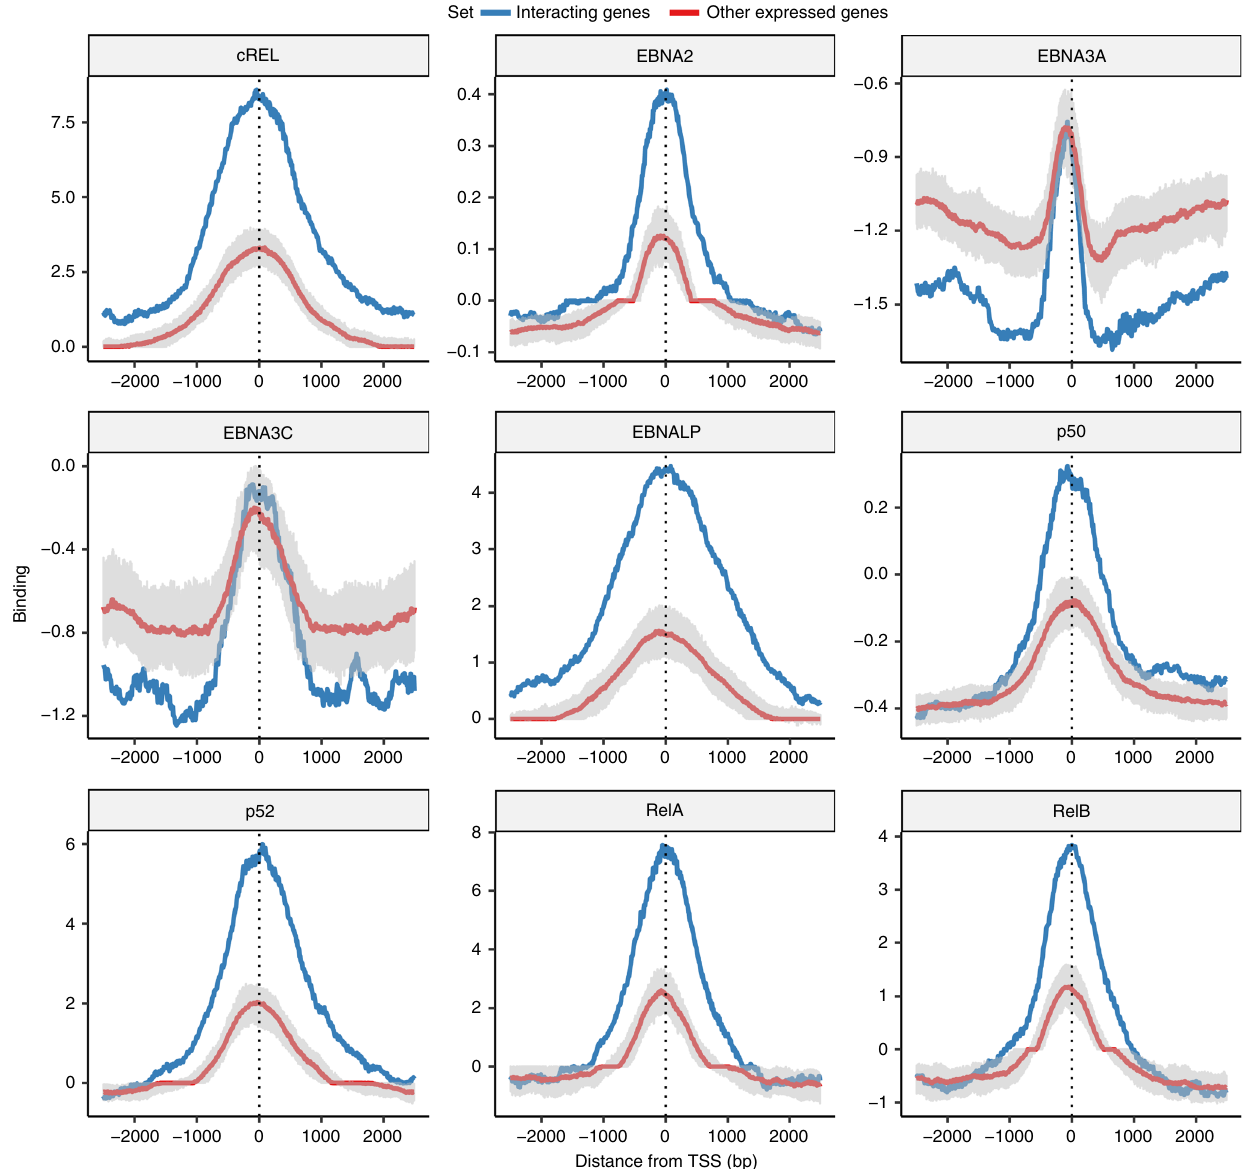
Fig. 6 Binding of key EBV-associated transcription factors at the promoters of genes in the interaction networks. The median binding levels of four EBV nuclear antigens (EBNA2, EBNA3A, EBNA3C and EBNALP) and fi ve NF- κ B subunits (cREL, p50, p52, RelA and RelB) at the promoters of interacting genes (i.e., interacting gene B s. Blue line) as well as genes expressed and tested for an interaction but for which one was not observed (red line). The grey shaded area around the red line represents the 95% con fi dence interval calculated by sampling 100 times the same number of genes from this background set as were in the foreground set of interacting genes. The processed binding data used in this plot was obtained from Jiang et al. 16